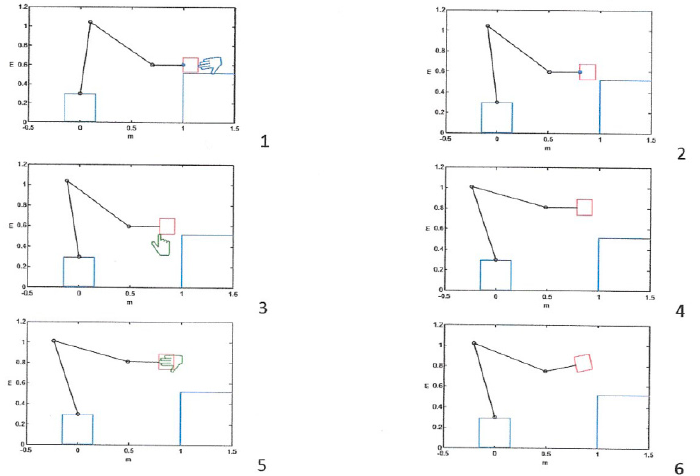
Figure 35. Selected phases of the interaction in the hypothesis of an impedance as shown in Figure 30b). (1–2 horizontal motion; 3–4 vertical motion; 5–6 angular motion).